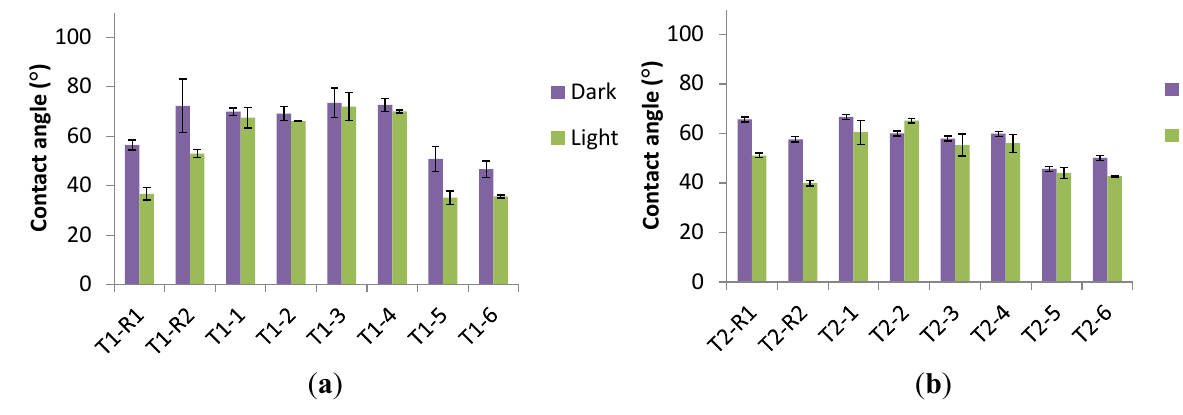
-Ag (high) (T3) and ( b ) TiO 2